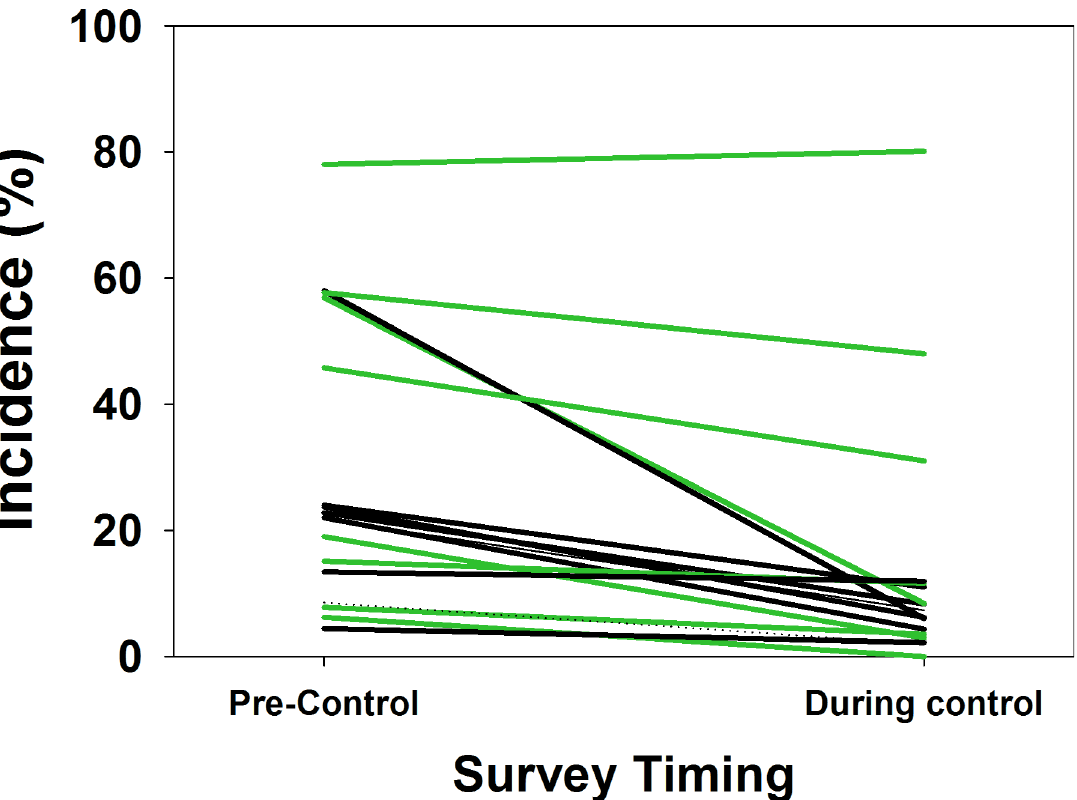
Fig 7. Change in local human incidence of Schistosoma infection during mollusciciding control projects. Individual lines represent the shift from pre- control incidence (left side) to incidence measured after implementation of chemical mollusciciding (right side) by schistosomiasis control programs. Black lines indicate programs that used niclosamide mollusciciding alone, green lines indicate programs that combined mollusciciding with anti-schistosomal drug treatments as part of control.